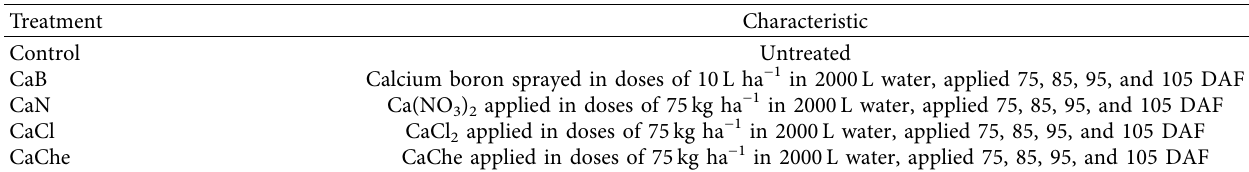
Table 3: Characteristics of the treatments used in the